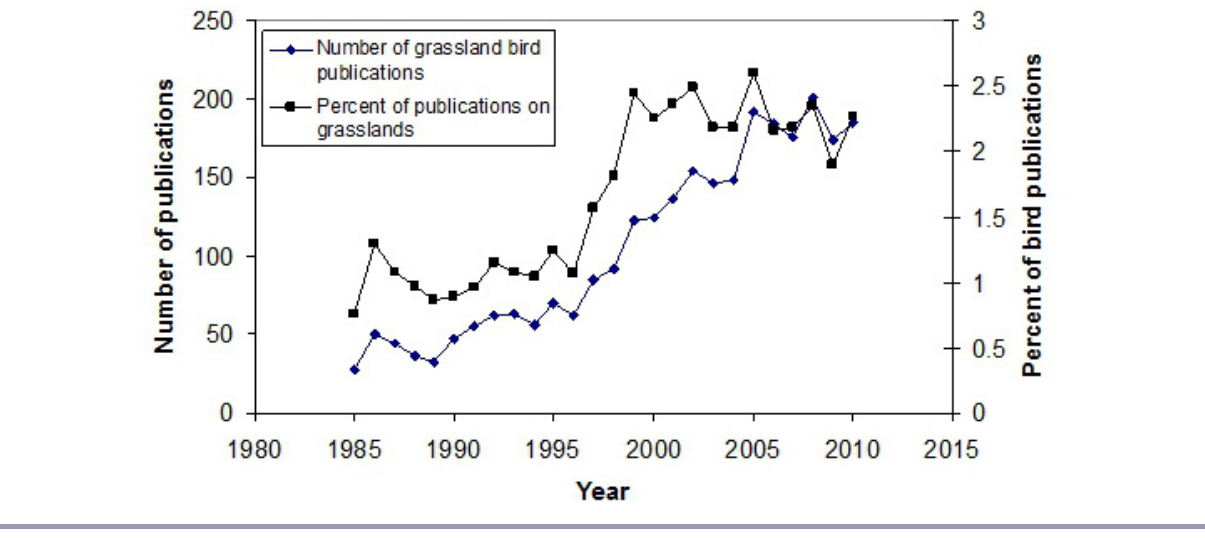
Fig. 1. Peer-reviewed publications on grassland birds between 1985 and 2010 as cited in ISI Web of